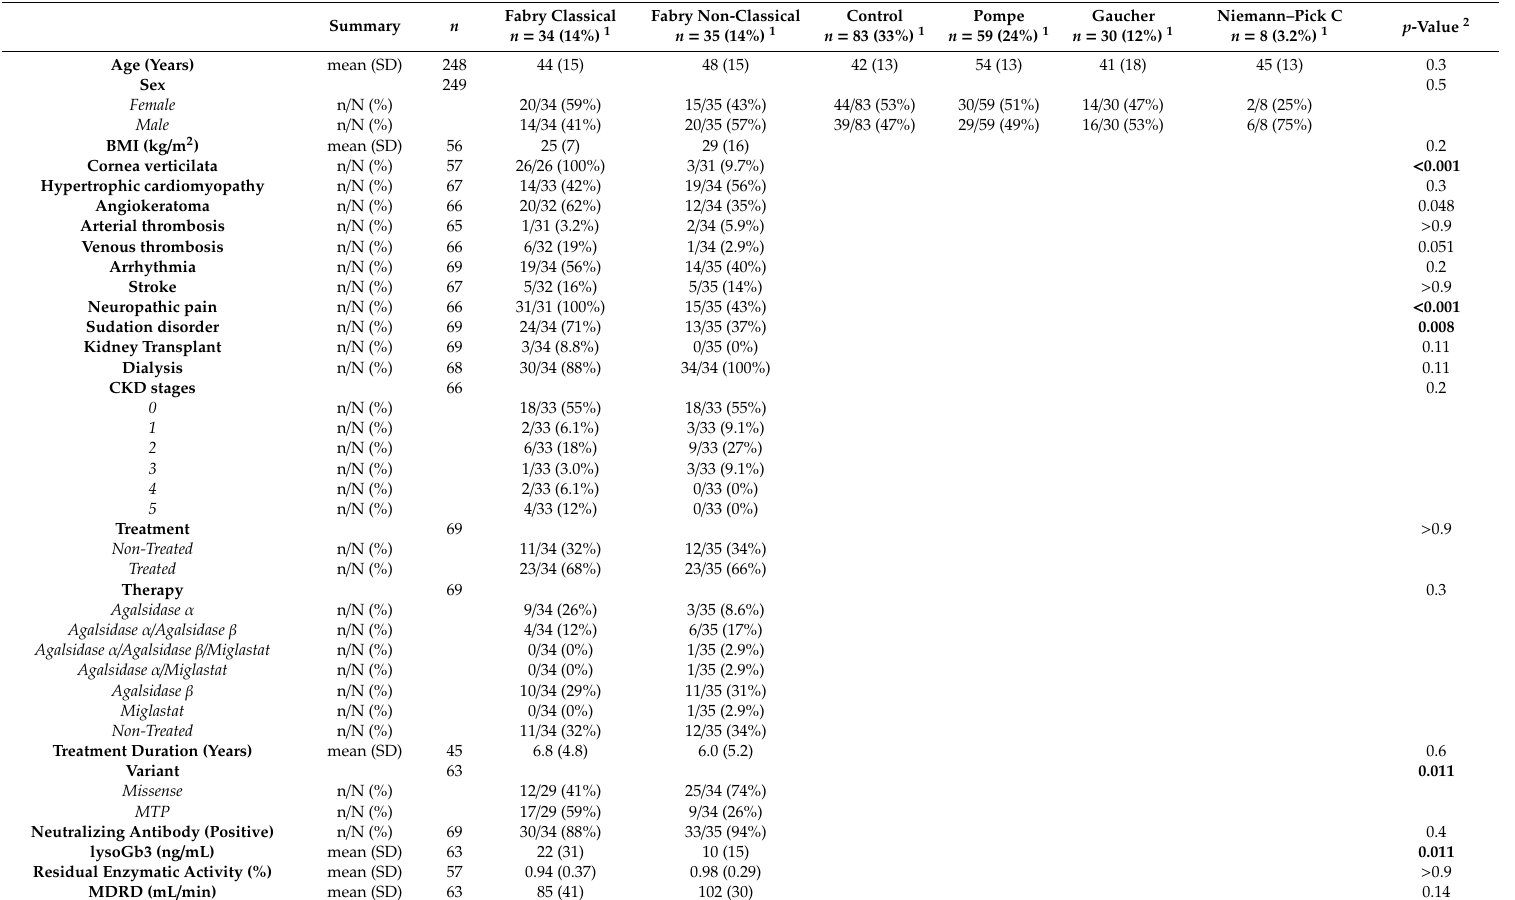
Table 1. Clinical characteristics of the